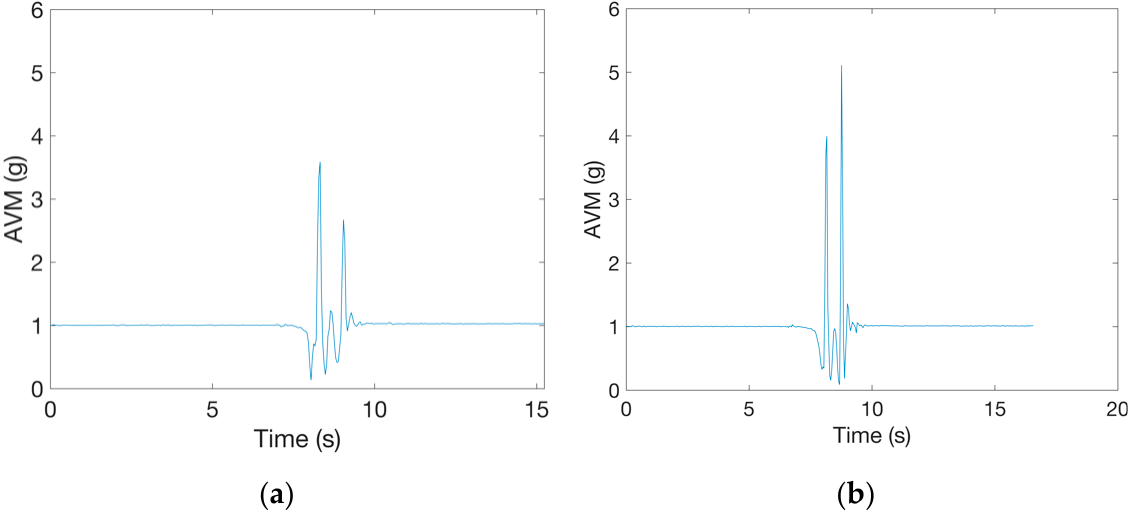
Figure 4. Examples of the same fall type from the ErciyesUni dataset simulated by two subjects: ( a ) the impact to the knees produces larger AVM peak than the impact of the body to the ground; ( b ) the AVM peak is larger when the upper part of the body impacts the ground.